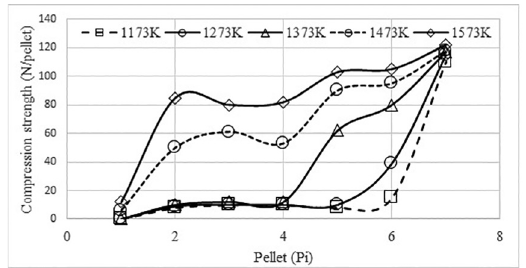
Figure 3: Effect of temperature on the compression strength of pellets with different binders after heat treatment during 30 minutes at varying temperatures before reduction.